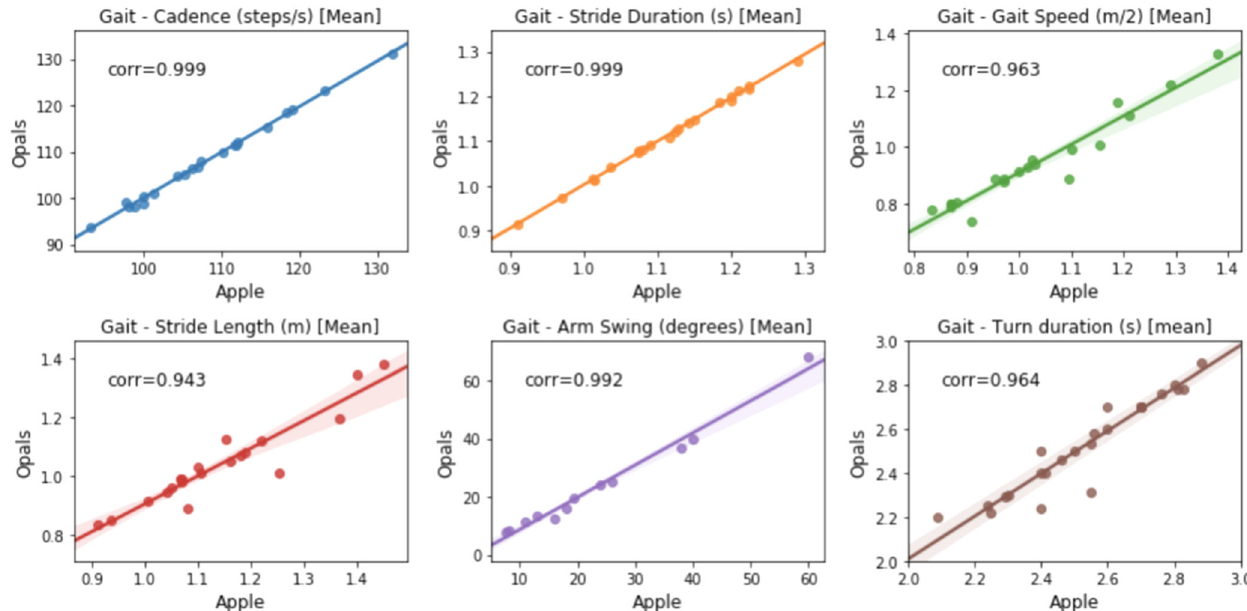
Fig. 4 Comparison against Consumer-grade Devices. Comparing features estimated using Opal versus consumer-grade devices using the software developed in-house. All features use iPhone measurements except arm swing that employs data sampled using the Apple Watch.